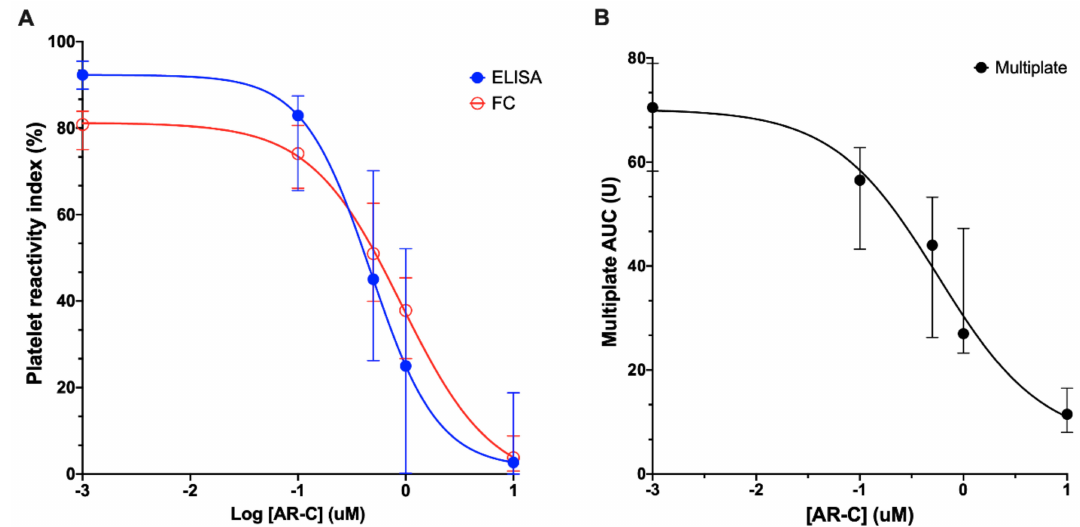
Figure1. InhibitionofplateletP2Y 12 activity. ( A )Concentration–responsecurvesofplateletinhibitionby AR-C 66096 as assessed by vasodilator-associated stimulated phosphoprotein (VASP) phosphorylation. Open symbols: flow cytometry. Closed symbols: ELISA. ( B ) Concentration–response curves of platelet inhibition by AR-C 66096 as assessed by the Multiplate ® analyzer. Data are presented as median and interquartile range. AUC: area under the curve.